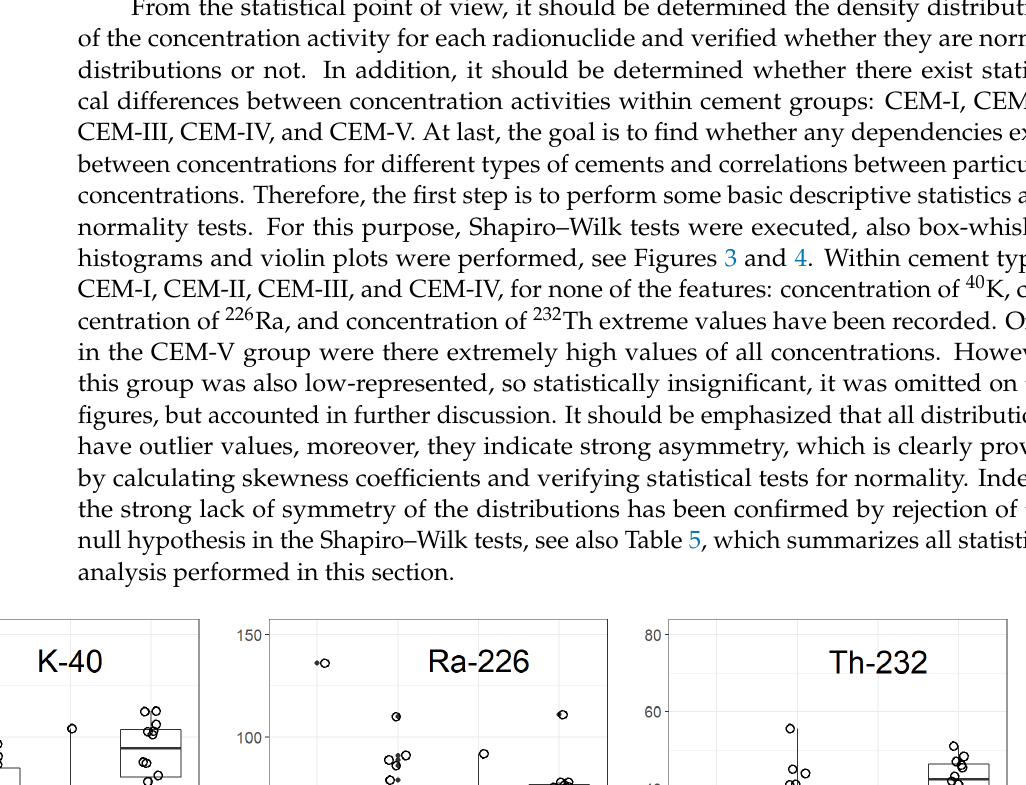
Figure 4. The violin-type plots of activity concentration of 40 K, 226 Ra and 232 Th. Data are grouped into “other studies” (left light-gray graphs) and “this study” (right dark-gray graphs). The violin-type plots are in fact a type of density plots and show how the measurements are distributed through the sample. Strong asymmetry is clearly visible in all plots for data from the other studies. Measurements performed by the authors reveal quite low asymmetry or even symmetry for 40 K concentration. Table 5. Descriptive statistics and results of statistical tests for all the gathered data, both experimental data from this study, and from other studies. Statistics